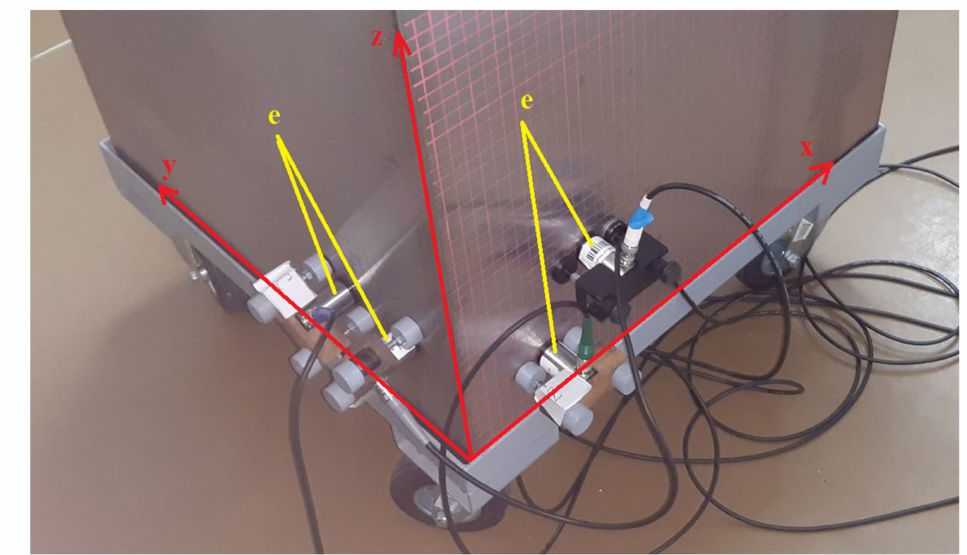
Figure 11. Photograph of the four Power Diagnostix AS 75l sensors mounted on the tank wall; the sensors were coupled to the tank’s wall, applying oil ( e ); the assumed directions of axes x , y , and z are also indicated.